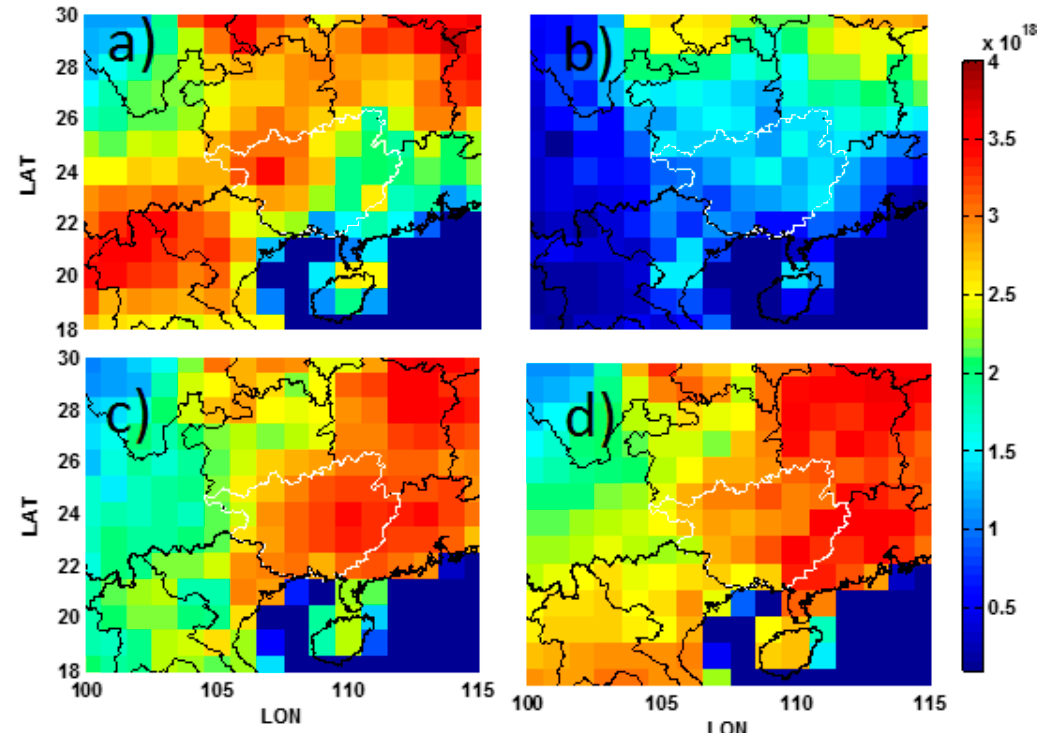
Figure 7. Seasonal-averaged MOPITT CO columns during the daytime for 2005–2016. ( a ) MAM; ( b ) JJA; ( c ) SON; ( d ) DJF.